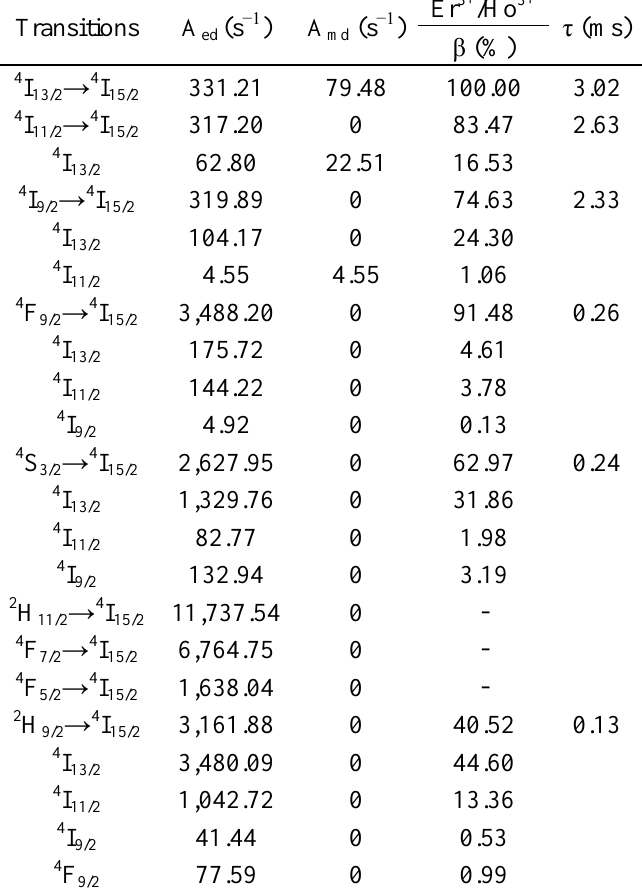
Table 3. The radiative transition probability of electric dipolar transitions (A transition probability of magnetic dipolar transitions (A radiative lifetime (τ ) of Er 3+ /Ho 3+ -codoped rad